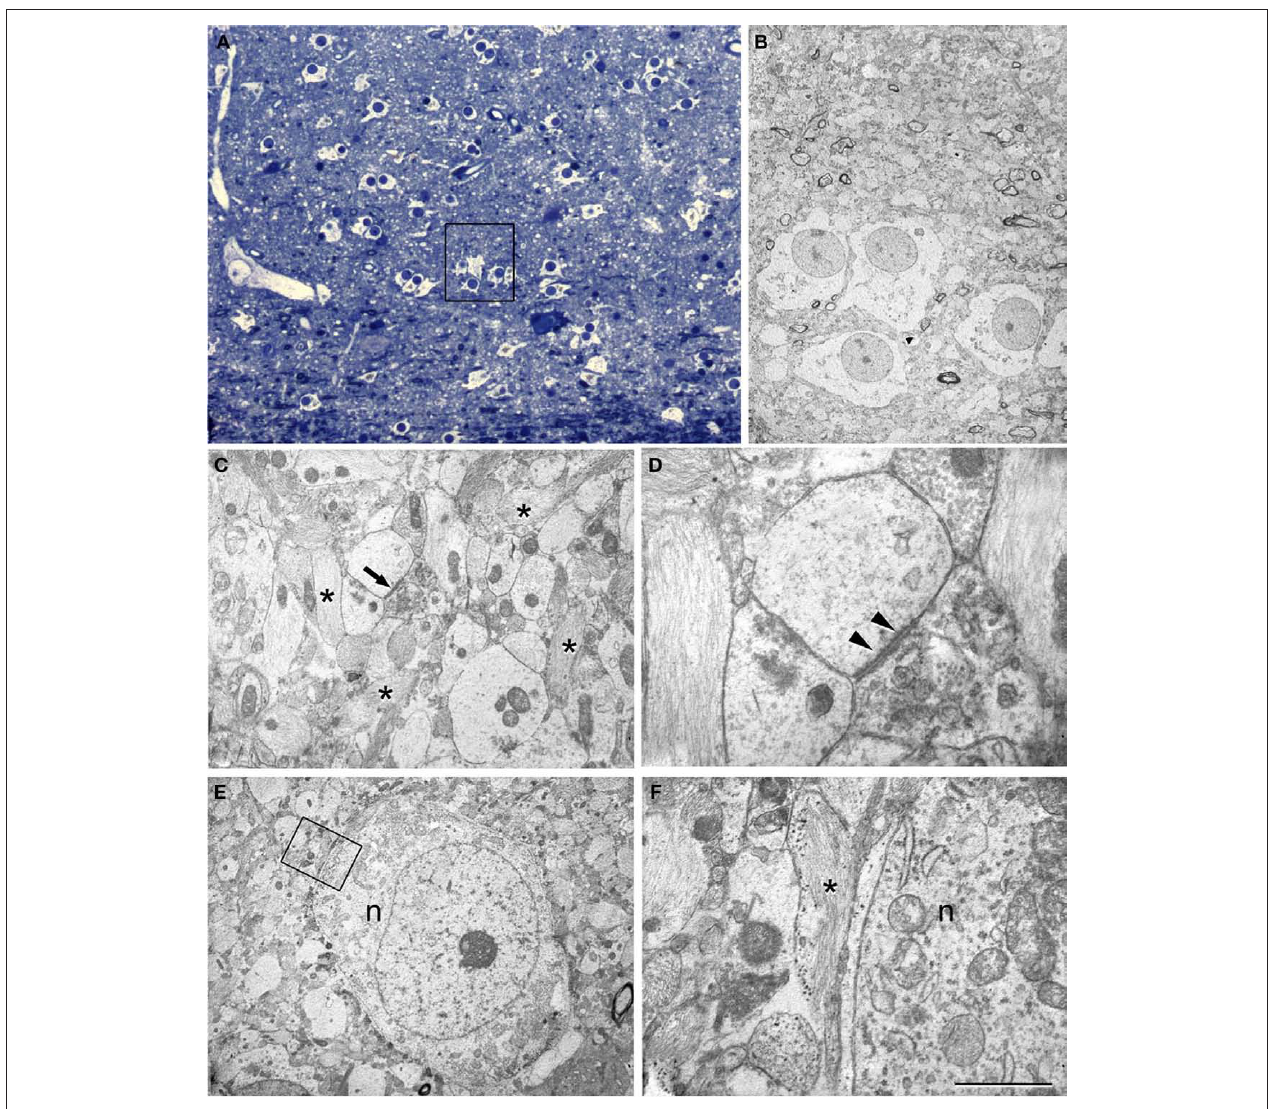
(arrow). (D) Higher magnification of the asymmetric synapse indicated with an arrow in (C) . Note that the presynaptic element is filled with degenerating structures and a prominent postsynaptic density is evident (arrowheads). (E) Electron micrograph of an isolated neuron (n) and its adjacent neuropil. (F) Higher magnification of the boxed area in (E) to indicate the presence of glial processes (asterisk) around the neuronal cell body (n). Scale bar [in (F) ]: 70 μm in (A) , 11